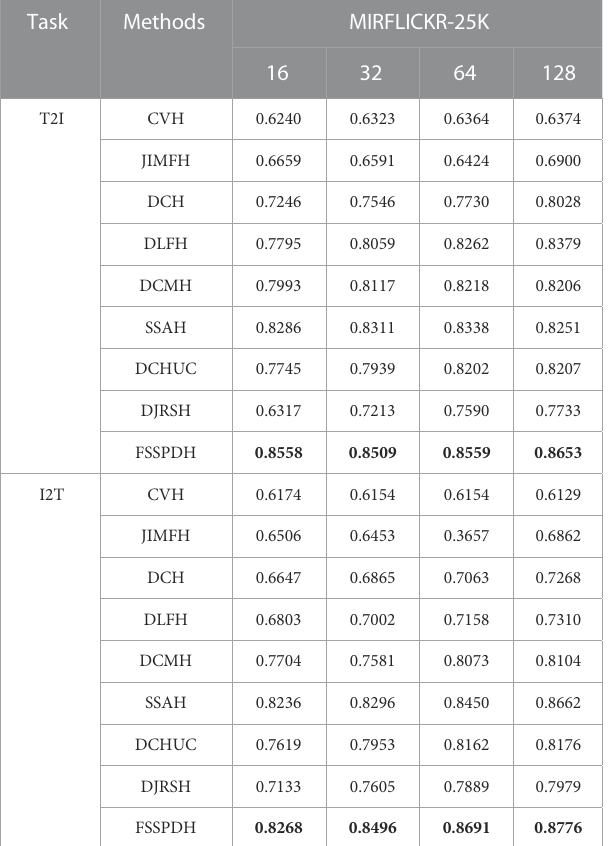
TABLE 2 The MAP values of cross-modal retrieval on MIRFLICKR-25K dataset. Task Methods